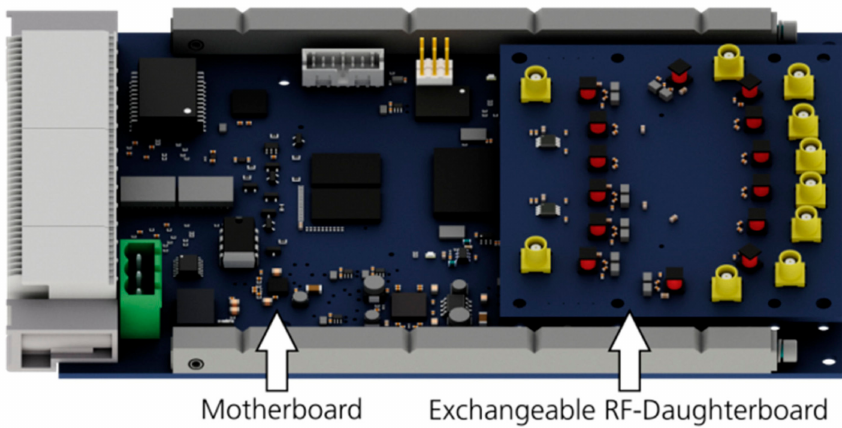
Figure 1. 3D-Model of the generic software-defined radio (GSDR)